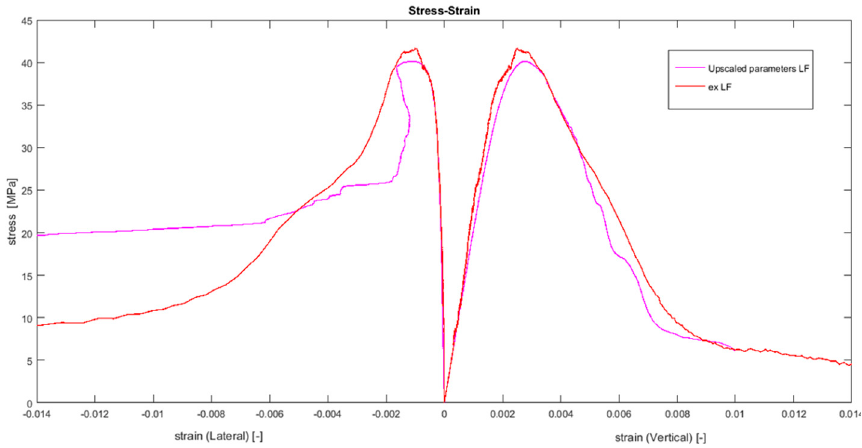
Figure 16. Uniaxial compression test; experimental and numerical results using upscaled parameters.